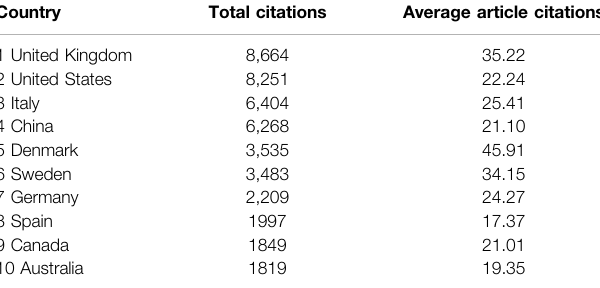
TABLE 3 | Number of citations of articles from different countries.